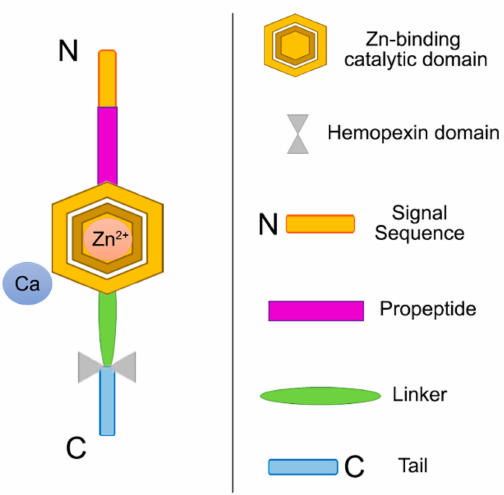
Figure 8. Schematic view of the modular domains of collagenases, a type of MMPs. MMPs are comprised of four domains; a signal peptide/sequence that is responsible of the protein secretion outside the cell; a propeptide region that is responsible for the inactivation of the enzyme until it is cleaved proteolytically; a catalytic domain with zinc and calcium where the propeptide region cysteine binds to inactivate it (cysteine switch); and a hemopexin-like domain that regulates substrate specificity and its interactions with endogenous inhibitors